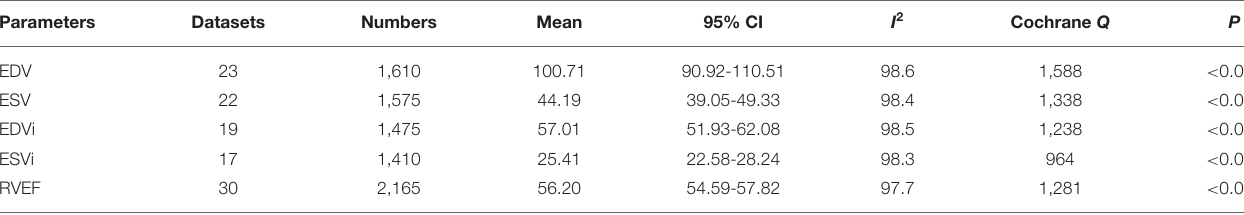
TABLE 2 | Summary of meta-analysis results of RV volumes by 3DE. Parameters